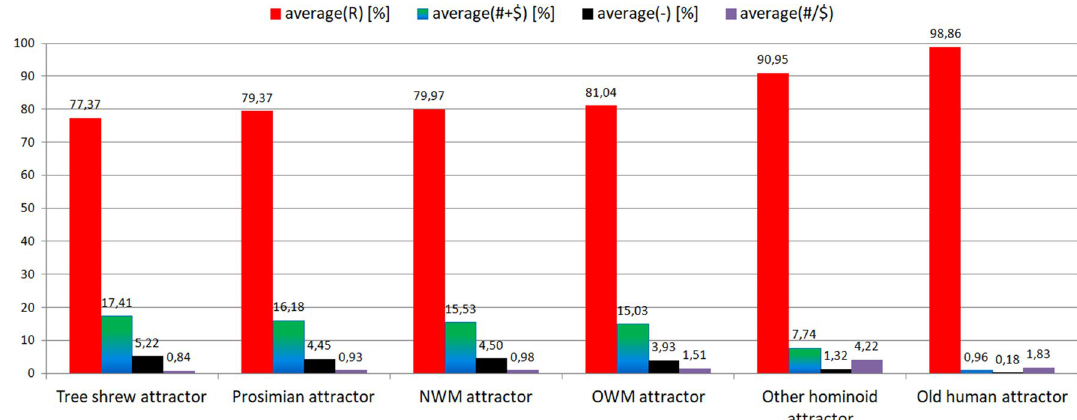
Figure 3. Characteristics of the genome attractors during Human evolution using semihomologous approach.